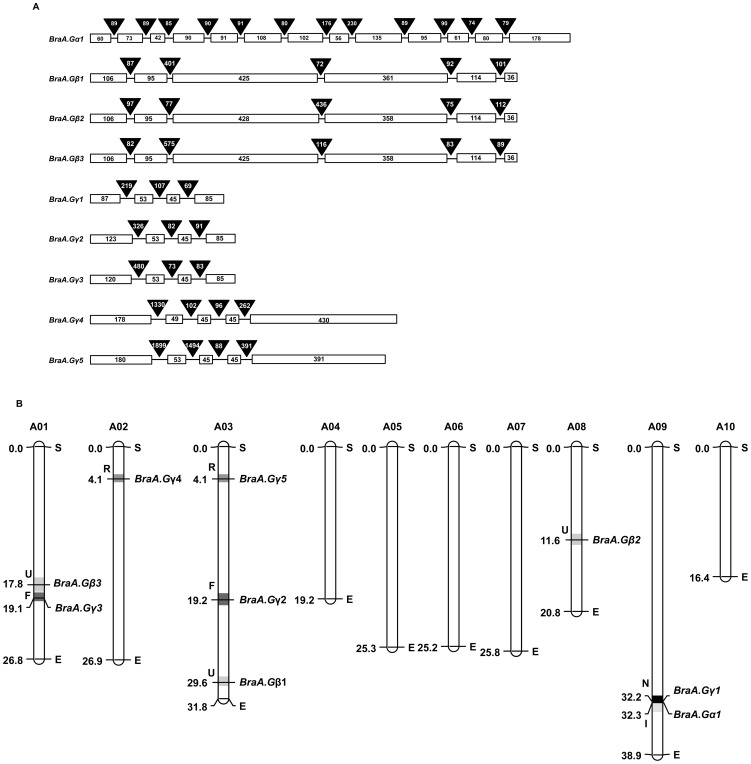
Genomic structure and chromosomal location of B. rapa G-protein genes.(A) Genomic structure of the identified G-protein subunit genes from B. rapa showing arrangement of the exons (open boxes) and introns (line with shaded triangle). Number denotes the length of respective exon and intron. The exons are drawn to scale. (B) Map of the B. rapa pseudo-chromosomes showing the distribution of the identified G-protein genes of B. rapa. The physical location (in Mbp) of G-protein genes is marked on B. rapa pseudo-chromosomes based recently available genome browser (chromosome v1.5) available at BRAD database (http://www.brassicadb.org/). S & E denotes the start and end of the chromosomes; and the letters (F, I, N, R and U) with shaded patterns represent the genomic blocks containing the G-protein genes. The pseudo-chromosomes were constructed using MapChart 2.2 (Wageningen).